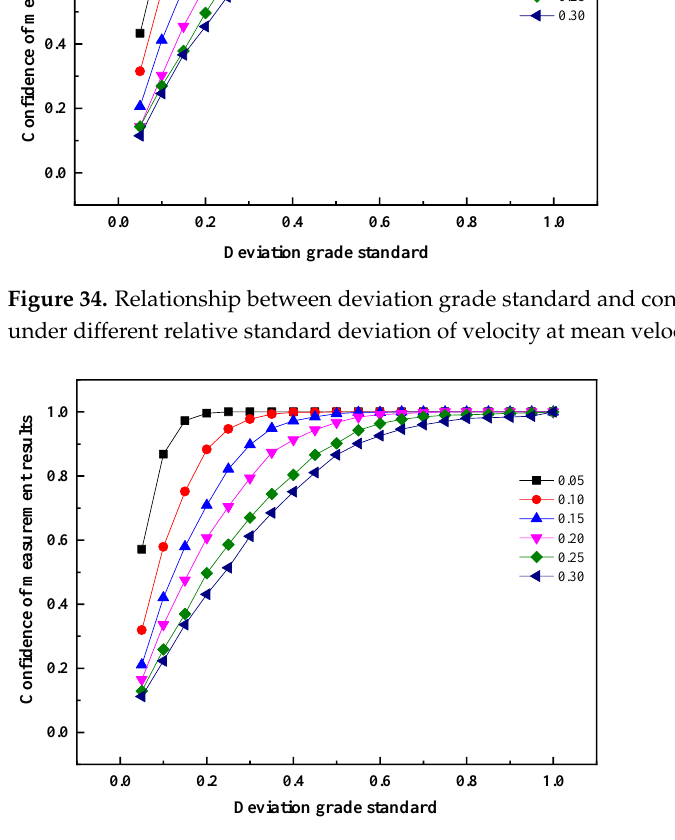
Figure 36. Relationship between deviation grade standard and confidence of measurement results under different relative standard deviation of velocity at mean velocity 5.05 m/s.